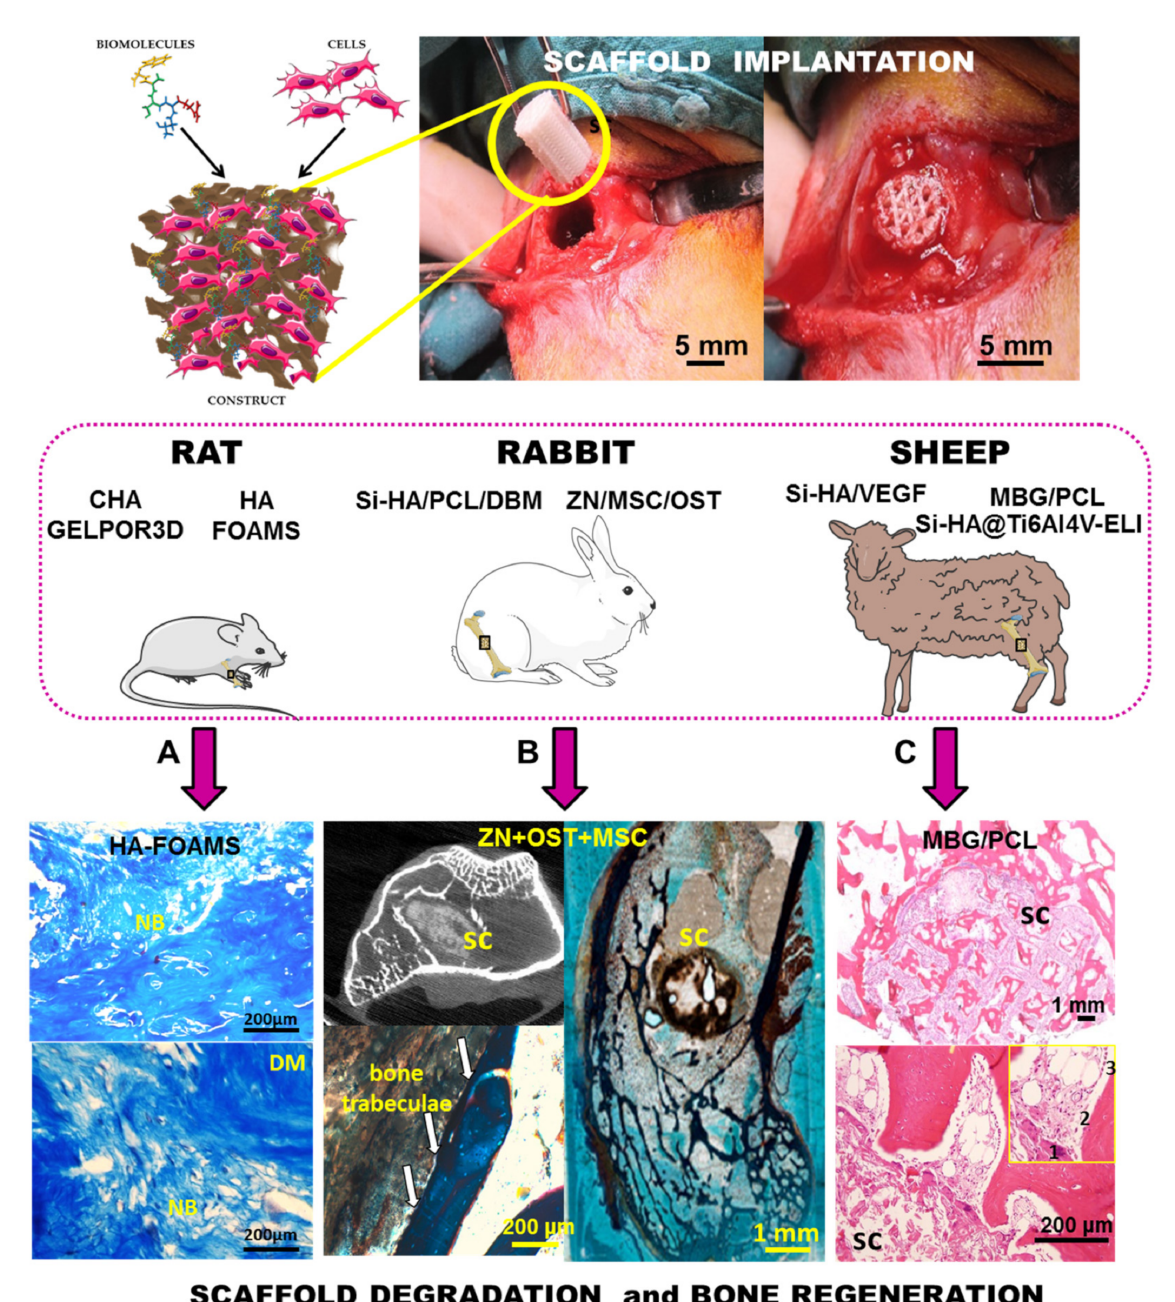
Figure 8. Illustration of the construct upgraded with biomolecules and cells. Photograph of its surgical implantation and the subsequent blood soaking within the recipient rabbit bone. Representative µ CT projection images and histological studies of the areas surrounding the different scaffolds (sc) implanted in different animal models: ( A ) CHA-GELPORE3D scaffolds extracted from subcutaneous implants of rat after 21 or 30 days and stained (hematoxylin–eosin): (1) skin, (2) fibrous capsule, (3) blood vessel, reproduced with permission from Ardura et al. [39], J. Biomed. Mater. Res. Part A; published by Wiley, 2016. ( B ) Masson–Goldner Trichrome sagittal stained sections of the area surrounding ZN+OST+MSC scaffolds loaded with osteostatin and decorated with MSCs, showing newly formed bone after 3 months of defect generation in the rabbit femur. In detail, bone trabeculae formed in intimate contact with the degraded material suggesting osseointegration (arrows), reproduced with permission from Lozano et al. [20], J. Mater. Sci. Mater. Med.; published by Springer, 2020. ( C ) Histological examination of MBG/PCL after 12 weeks of implantation. The inset shows (1) osteoclast cells, (2) blood vessel and (3) the osteoblast border, reproduced with permission from G ó mez-Cerezo et al. [17], Acta Biomater.; published by Elsevier,